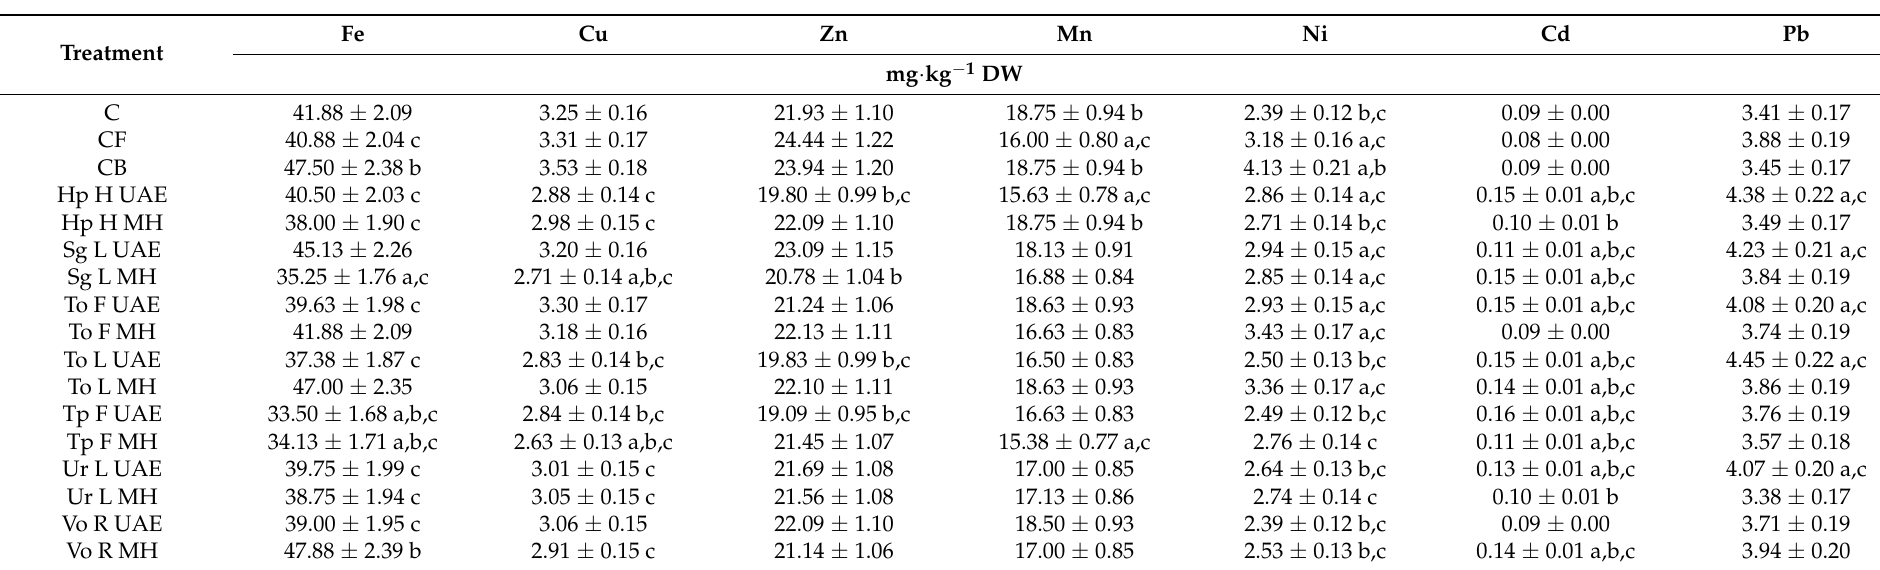
Table 5. Effect of the foliar application of the botanical extracts on the microelements and toxic elements content of cabbage head after harvest ( n = 3, mean ± SD).